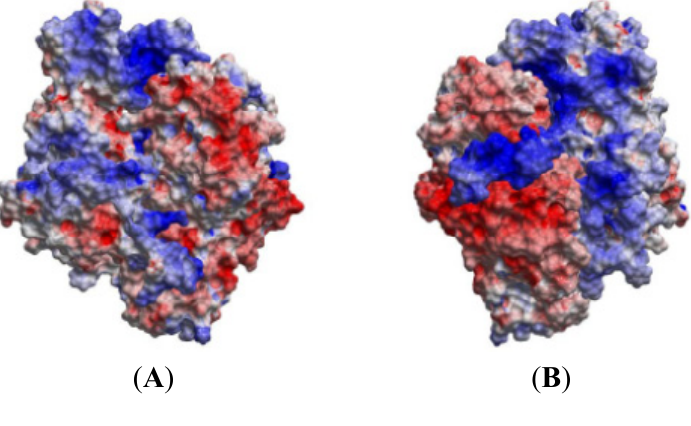
Figure 11. Skin representation of the molecular electrostatic potential surface (EPS) coloured according to the electrostatic potentials. Colour coding: red; ESP < − 5 kcal/e.u. charge units, blue; >+5 kcal/e.u. charge units, grey: between − 5 and +5 kcal/e.u. charge units. ( A ) Entire complex in the same view as in Figure 8; ( B ) Entire complex rotated 180 degrees ( y -axis) compared with ( A ); ( C ) The EPS of MK5 with backbone C α -trace of p38 α in yellow. Same view as in ( A ); ( D ) Same as in c, but rotated 90 degrees ( y -axis) compared with ( C ); ( E ) The EPS of p38 α and the backbone C α -trace of MK5 in green. The same view as in ( A ); ( F ) Same as in ( E ), but rotated 90 degrees ( y -axis) compared with ( E